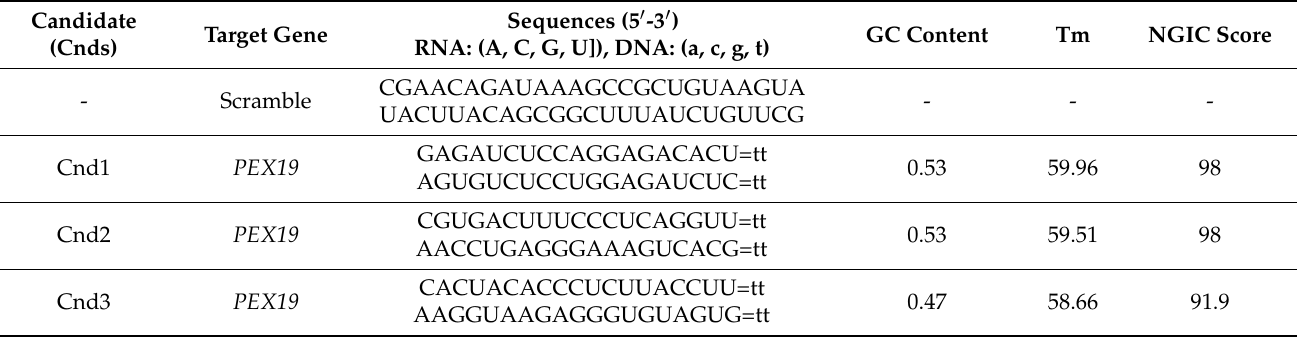
Table 1. List of candidate siRNAs targeting Pex19 and scramble